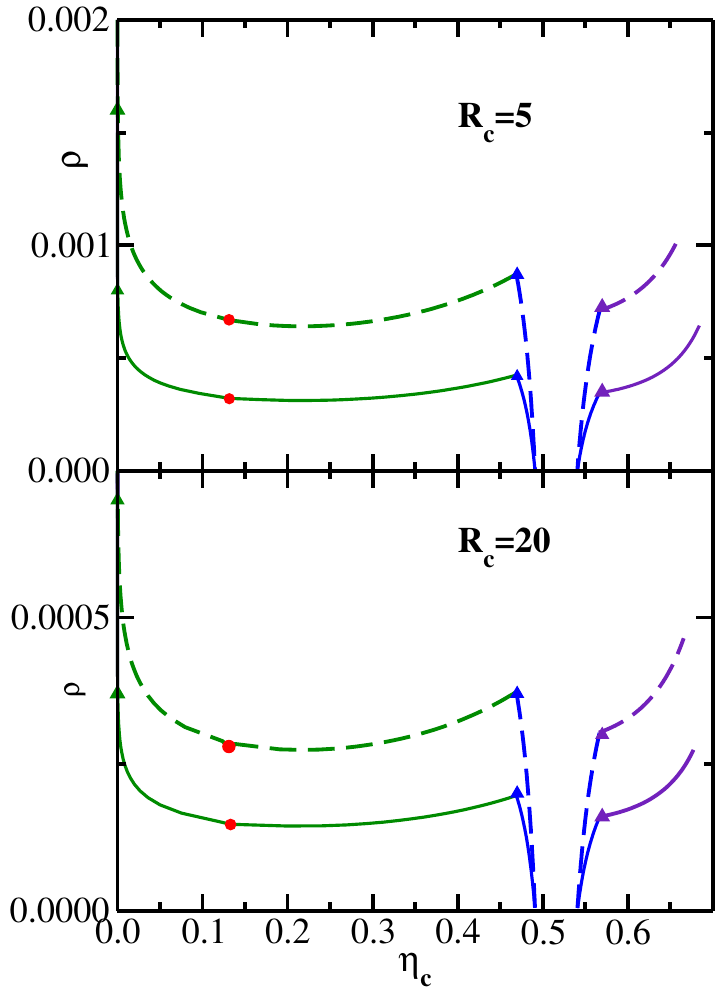
Figure 3. Same as Figure 2 but in the system representation in the variables η c – ρ . It follows from the results shown in Figure 2 that the monomer reservoir density ρ rc (which corresponds to the liquid–vapor critical point), as well as ρ rt (the monomer reservoir density corresponding to the vapor–liquid–solid triple point), both decrease with increasing chain stiffness κ . This behavior is further illustrated in Figure 4, which plots both ρ rc and ρ rt as functions of the inverse stiffness parameter κ − 1 . The upper panel presents the results for the colloid radius R c = 5, while the lower panel shows the results for the colloid radius R c = 20. For both values of the colloid size, ρ rc and ρ rt increase nearly linearly with κ − 1 . Furthermore, the slope of the triple point line ρ rt is significantly higher than the slope of the critical point line ρ rc . This behavior is indeed consistent with the phase diagrams shown in Figure 2, where one sees that an increase in chain stiffness (going from dashed to solid phase boundaries) leads to a substantially larger drop in ρ rt (marked by triangles) compared to the drop in ρ rc (marked by